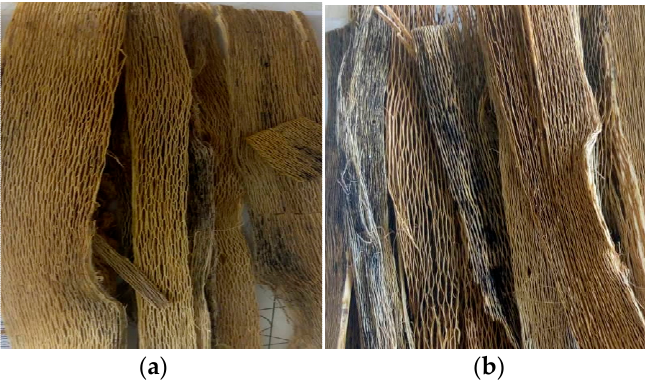
Figure 1. Photographic representations of chemically treated pawpaw stem fibers. ( a ) Extracted and treated linear fiber ( b ) Extracted and treated network fiber.